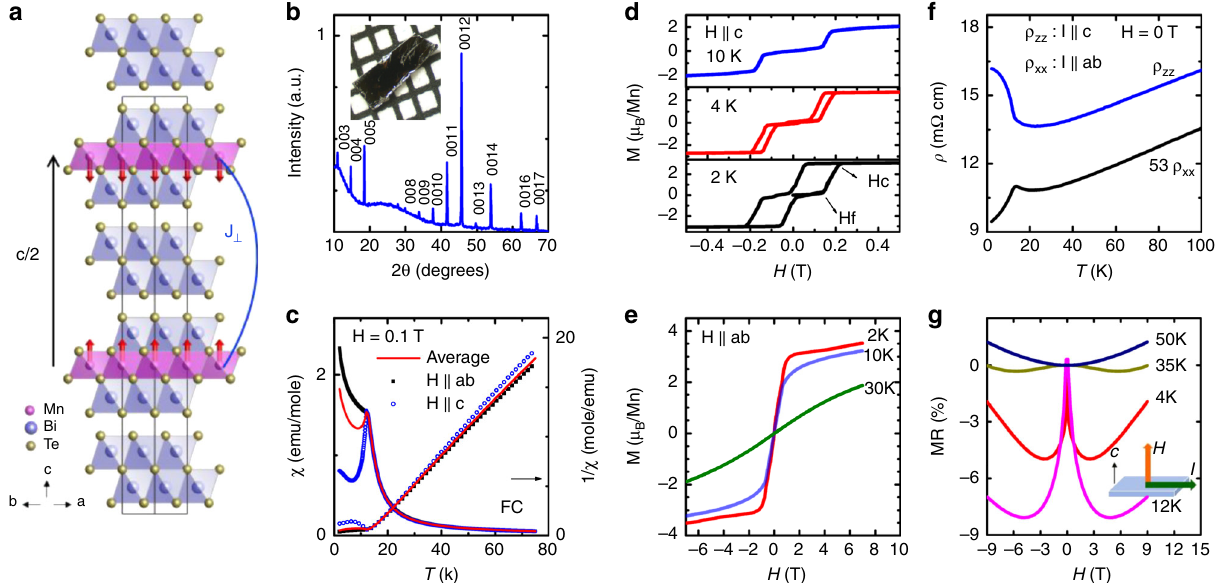
Fig. 1 Magnetic and transport properties of bulk AFM MnBi 4 Te 7 . a The view of the crystal structure of MnBi 4 Te 7 from the [110] directions. Red arrow: Mn spins in the A-type AFM state. Blue block: edge-sharing BiTe 6 octahedra; Pink block: edge-sharing MnTe 6 octahedra, which are connected to the blue block via edge-sharing. J ⊥ is the interlayer exchange coupling. b The (00 l ) X-ray diffraction peaks of the cleaved ab plane of MnBi 4 Te 7 . Inset: A piece of MnBi 4 Te 7 against 1-mm scale. c The temperature dependent fi eld-cooled susceptibility and inverse susceptibility taken at H = 0.1 T for H || ab and H || c . Average χ is calculated by χ ave ¼ ð 2 χ ab þ χ c Þ = 3. d and e : Full magnetic hysteresis loop of isothermal magnetization taken at various temperatures for: d H || c and e H || ab . f The temperature dependent ρ xx ( I || ab ) and ρ zz ( I || c ). g Transverse magnetoresistance with I || ab and H || c at various